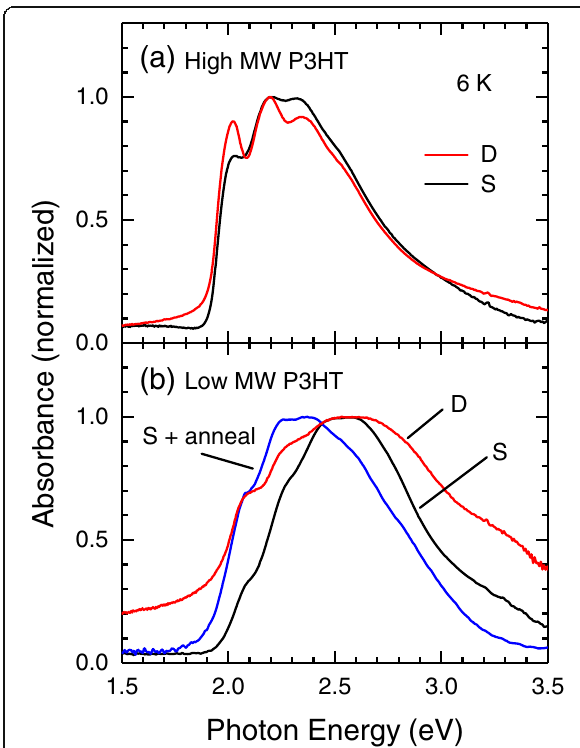
Fig. 2 Normalized absorption spectra of thin films of a high and b low MW P3HTs at 6 K. S and D mean the samples prepared by spin-coating and drop-casting, respectively